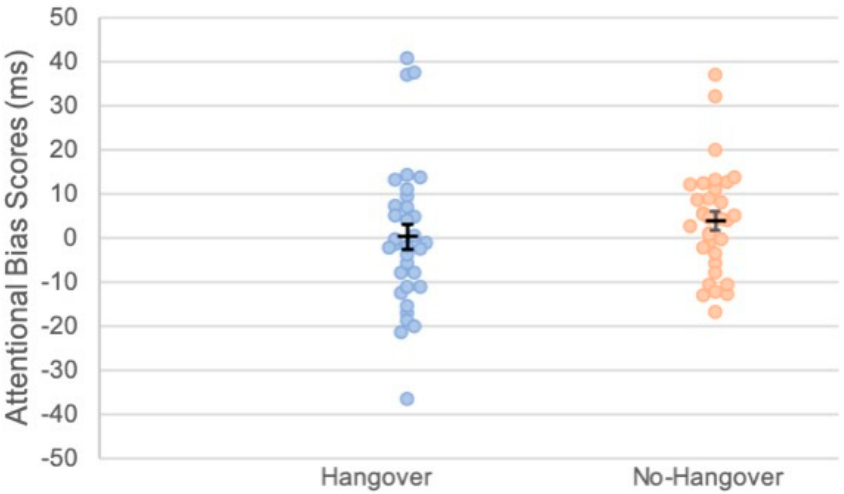
Figure 3. Scatter plot showing attentional bias scores towards alcohol-related stimuli for each condition. Each dot represents an individual participant’s score. Black bars indicate mean attentional bias scores. Error bars represent ± 1 standard error of the mean.